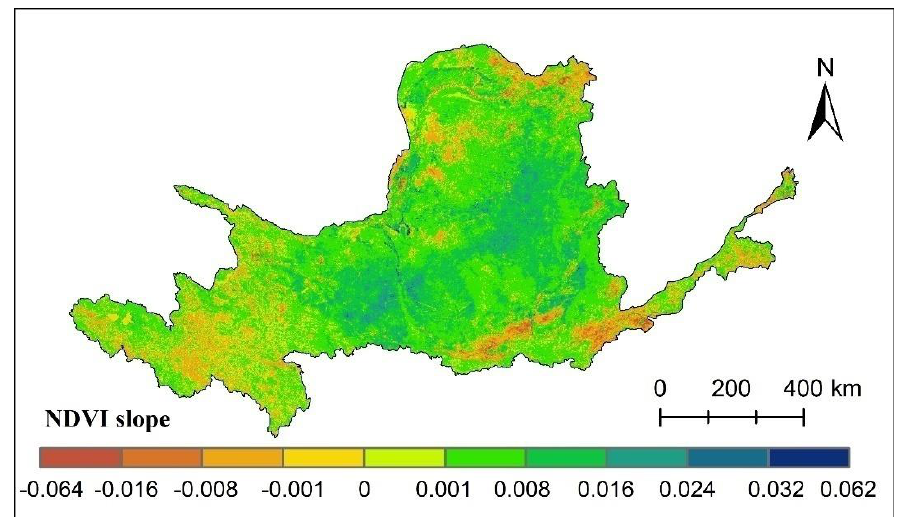
Figure A2. Annual NDVI trends in the YRB during the years 2003–2015. NDVI slope is the change rate of the annual NDVI, which is calculated using Equation (12).